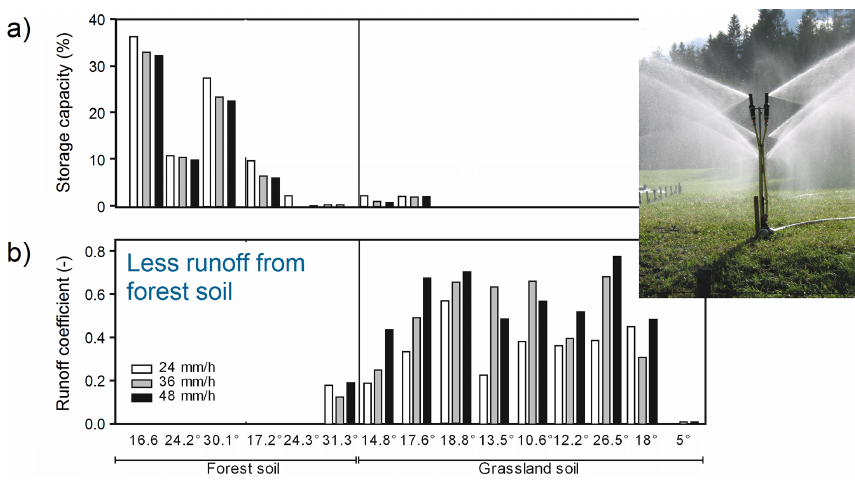
Figure 3. Effect of land use on flood generation from irrigation experiments (see inset photo) in the Bernese Oberland in Switzerland. (a) Storage capacity of the soil (defined as the difference between total porosity and maximum soil moisture measured during infiltration). Each group of three bars gives the results for an experimental site. The grey shades represent different irrigation intensities. (b) Runoff coefficient (defined as the proportion of irrigation water that runs off the surface and does not infiltrate). The forest soils produce much less surface runoff than the grassland soils. Photo: Gerhard Markart (Alaoui et al., 2018).